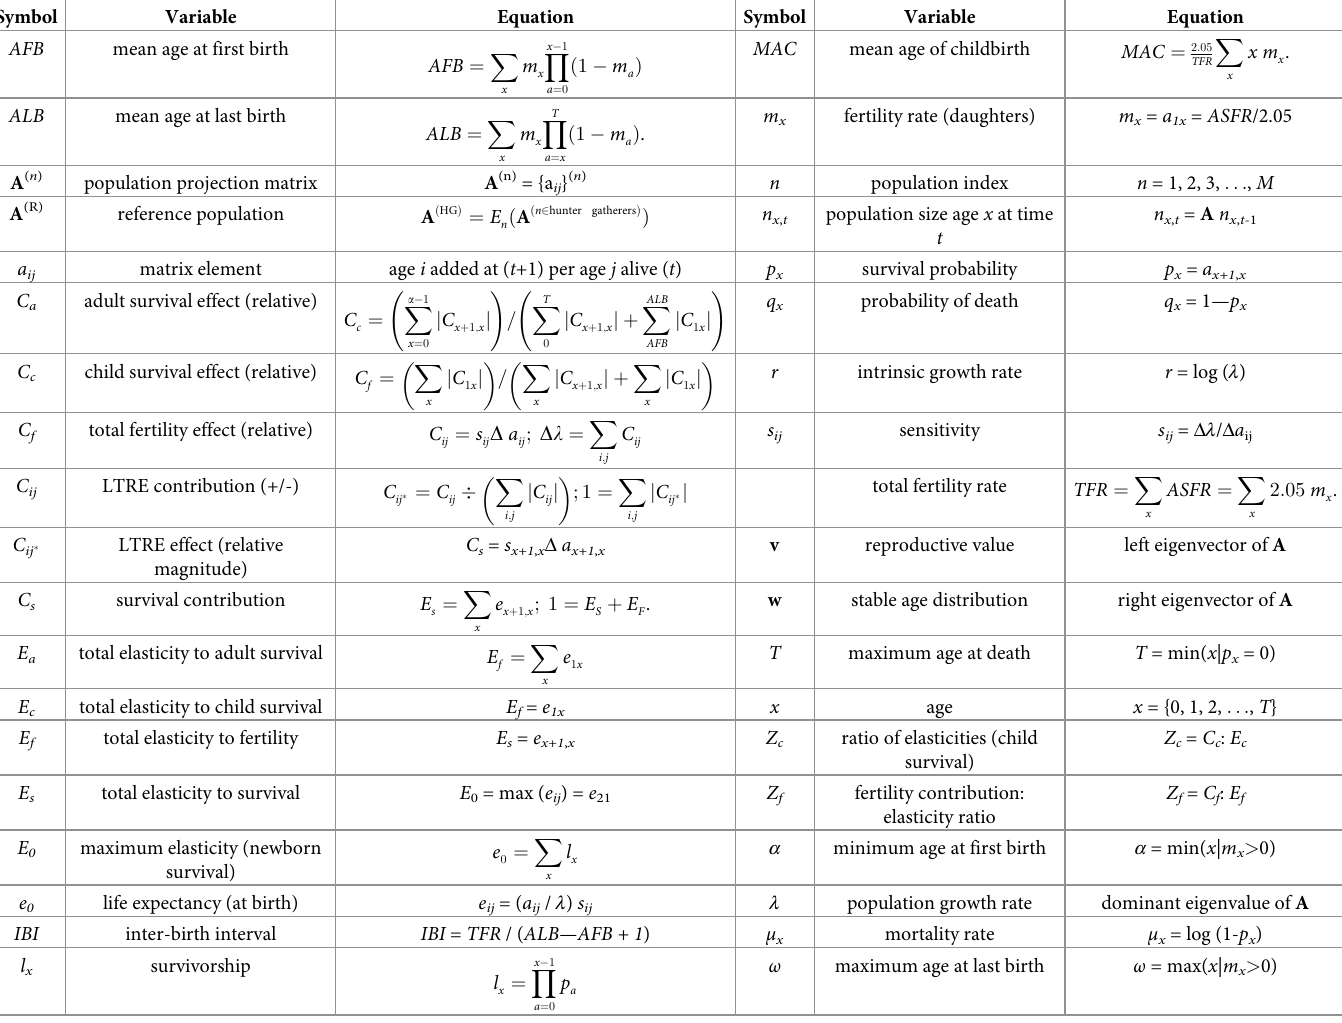
Table 1. Variable